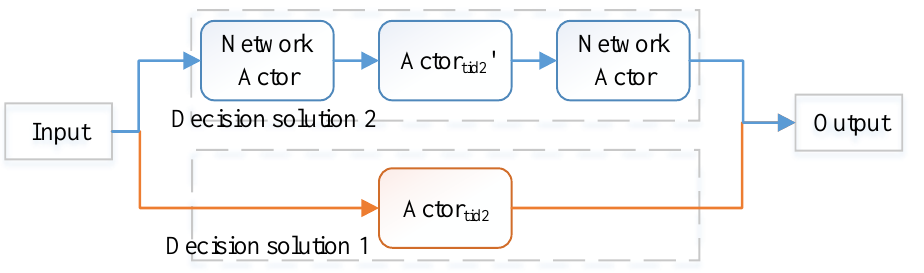
Figure 15. Actor is closed under substitution and concatenation.